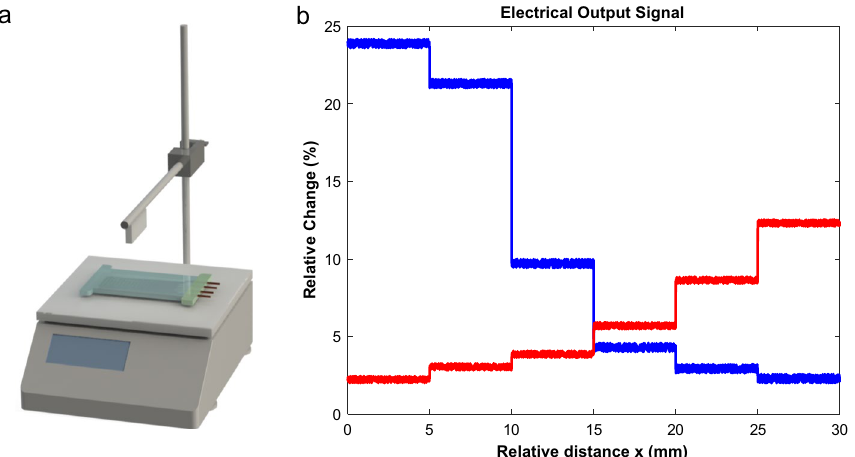
Figure 11. ( a ) Schematics of the setup for experimenting output response of the soft sensor to the force along Z direction. ( b ) Experiment results of electrical signal due to applying the perpendicular force of 3 N on different points of the Soft Sensor Type-2. Blue and red colors refer to L and W sensors, respectively.